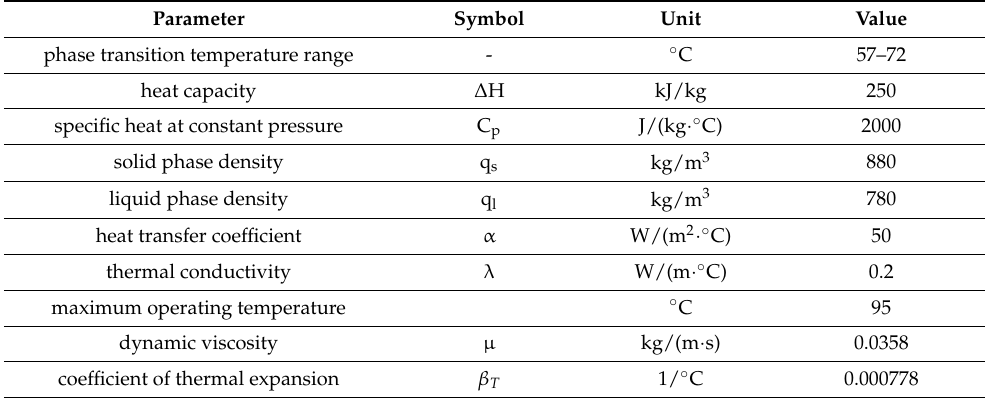
Table 1. Properties of the PCM used [34].